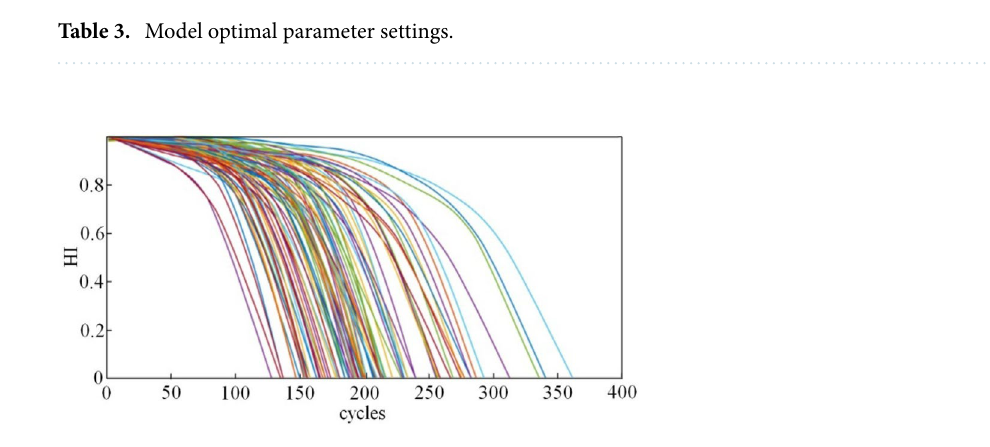
Figure 6. HI curve of the 100 engines.